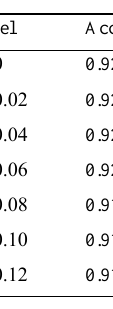
Table 7. Weight model accuracy on test